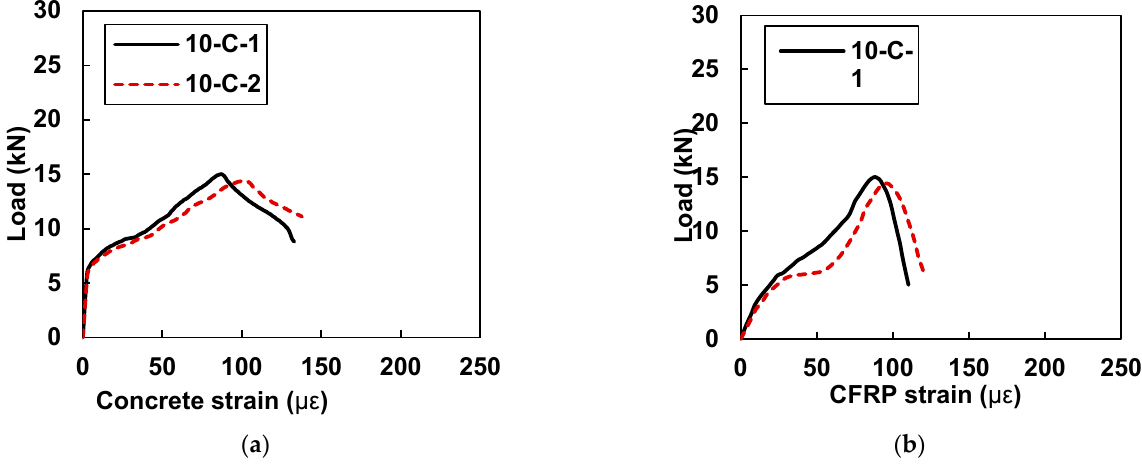
Figure 12. Load vs. concrete strain for samples C-1 and C-2.